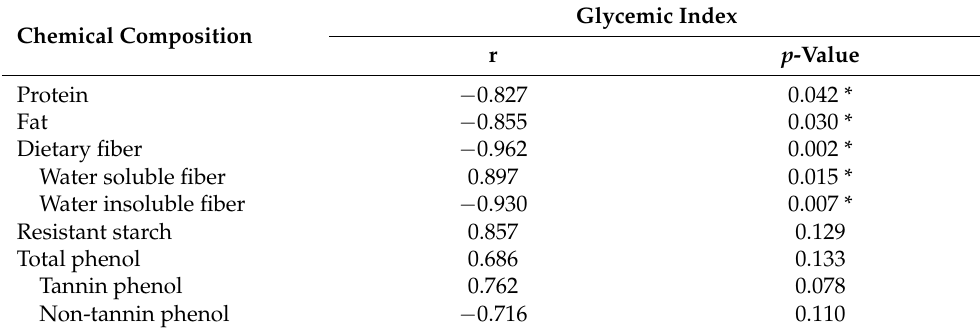
Table 5. Correlation between chemical compositions and the glycemic